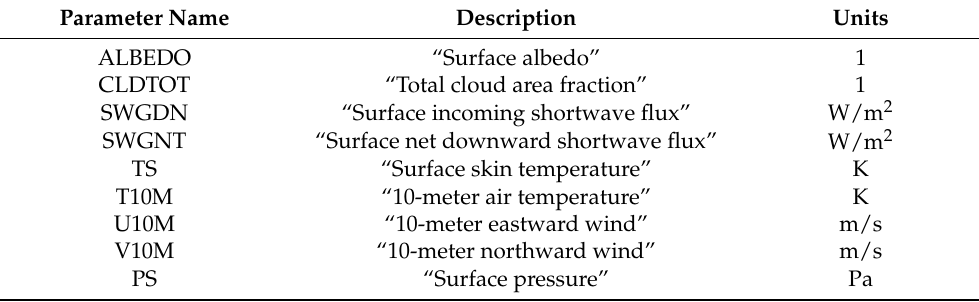
Table 1. Some sample parameters in the RAD and SLV datasets of Modern-Era Retrospective analysis for Research and Applications version 2 MERRA-2